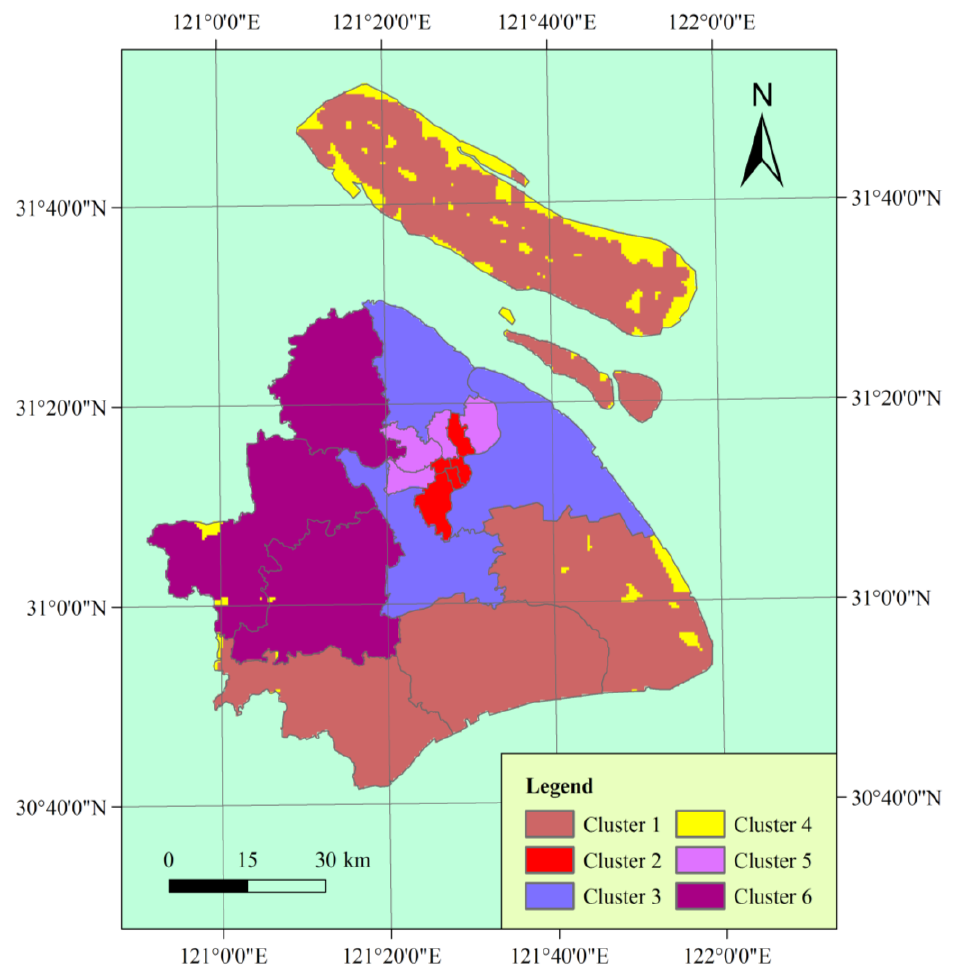
Figure 5. Vulnerability mapping of the study area.